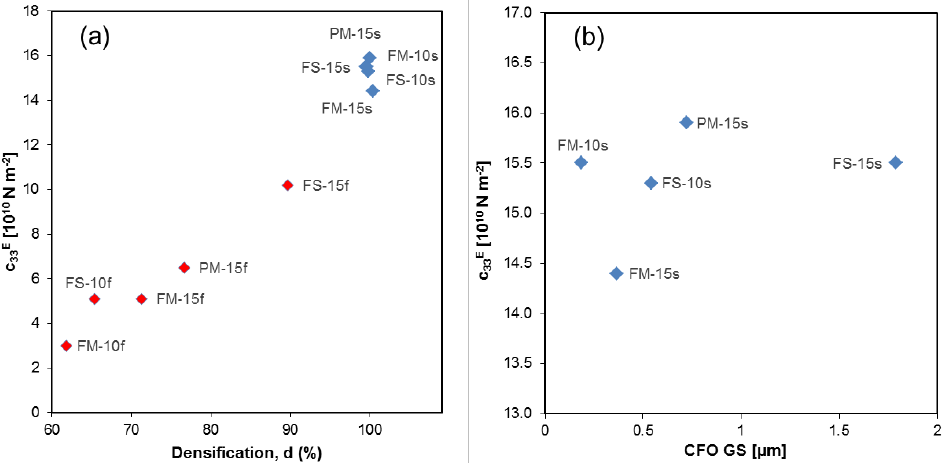
Figure 8. ( a ) c 33E vs. relative density. ( b ) c 33E vs. CFO grain size. Fast‐sintered samples are shown as red diamonds, slow‐sintered samples as blue